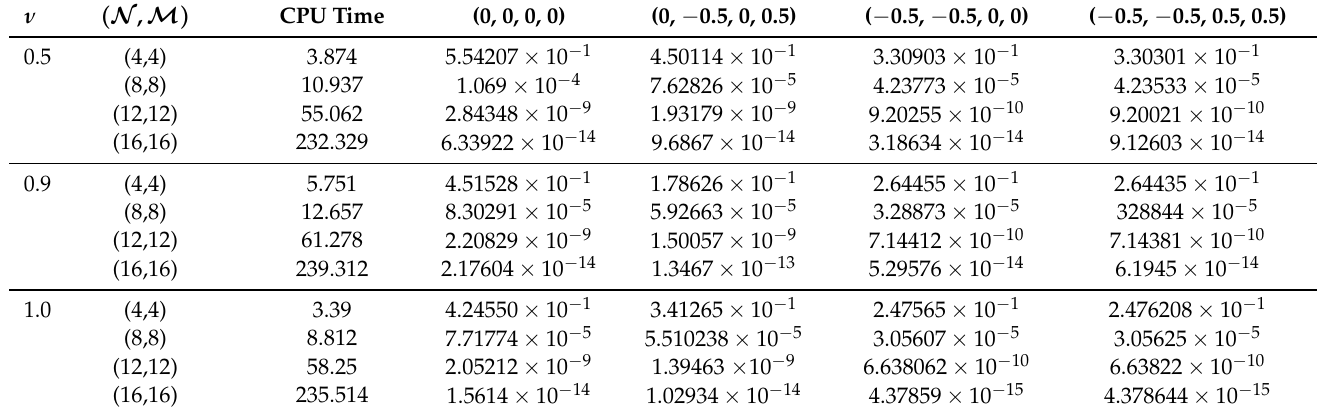
for problem (30). U